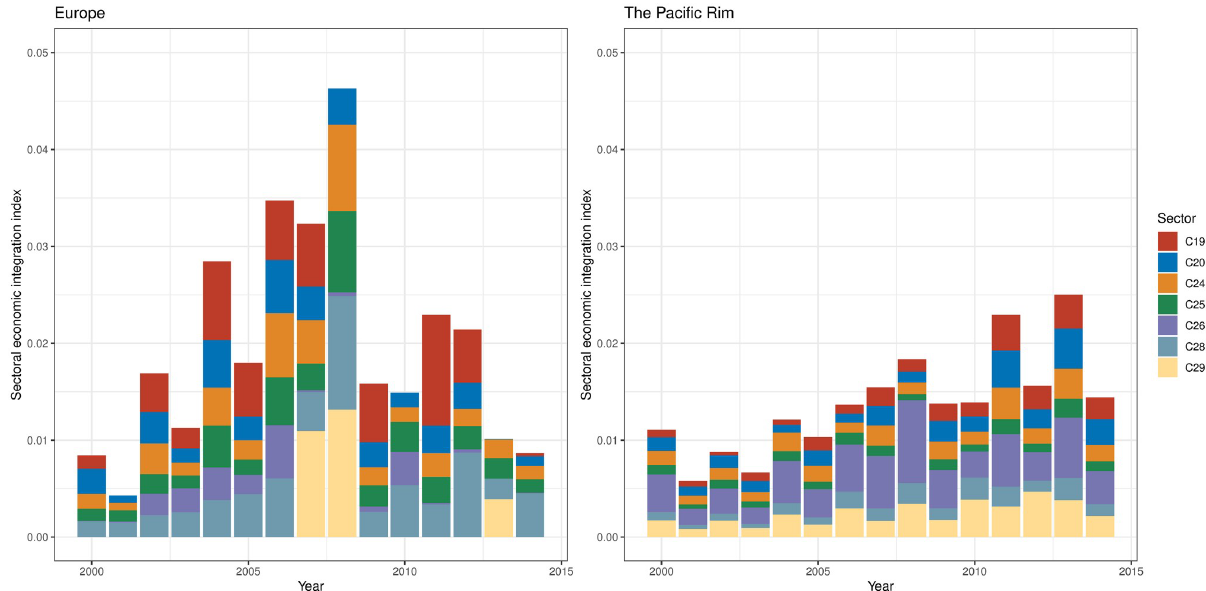
Fig 10. Sectoral economic integration index of manufacture in two regional communities. C19: manufacture of coke and refined petroleum products; C20: manufacture of chemicals and chemical products; C24: manufacture of basic metals, C25: manufacture of fabricated metal products except for machinery and equipment; C26: manufacture of computer, electronic, and optical products; C28: manufacture of machinery and equipment n.e.c.; C29: manufacture of motor vehicles, and trailers and semi-trailers.